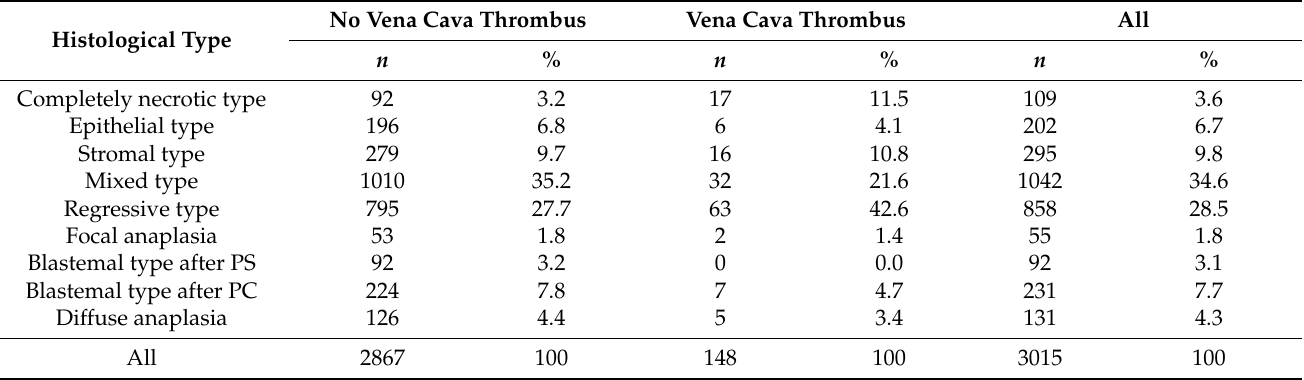
Table 1. Distribution of vena cava thromboses according to histology ( p < 0.001) at time of